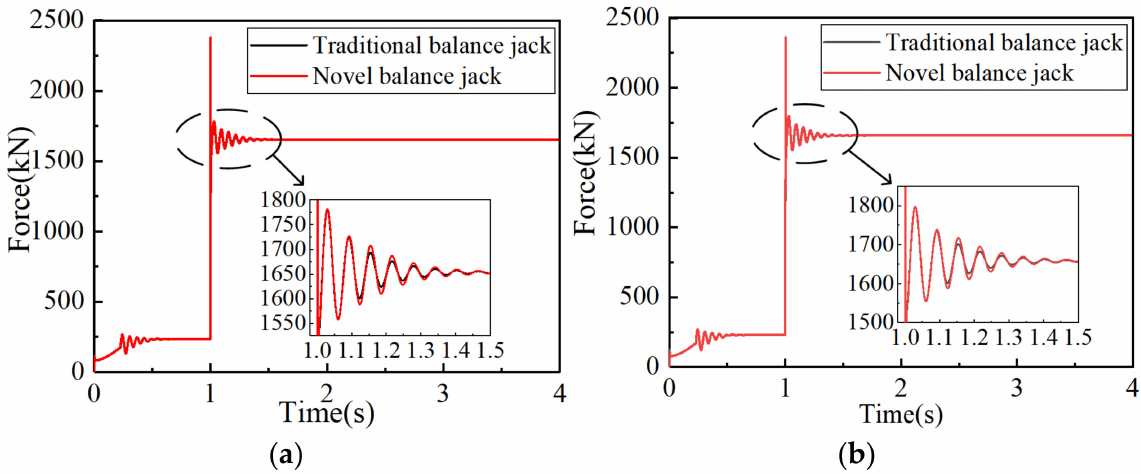
Figure 7. Force at hinge point: ( a ) The hinge point of top beam-balance jack. ( b ) The hinge point of shield beam-balance